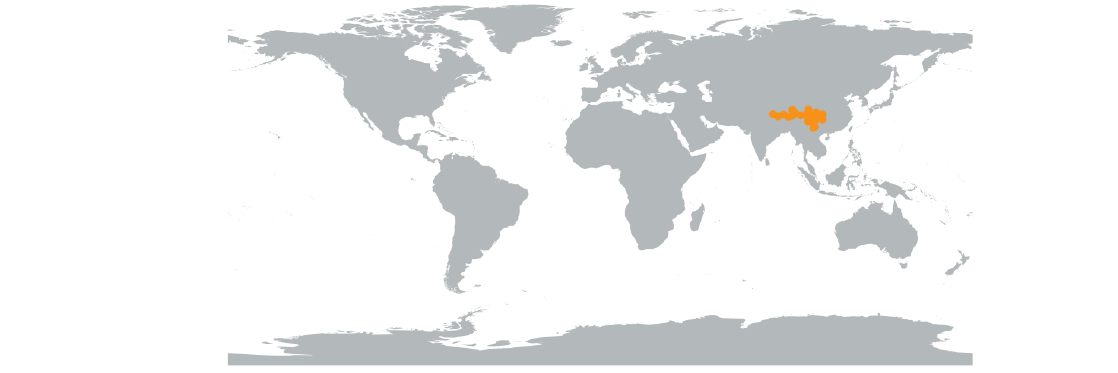
Fig. 25. Distribution of Malus rockii Rehder